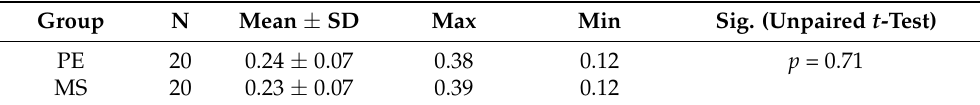
Table 3. Descriptive statistics and results of the unpaired t -test for comparing load values of the groups ( n